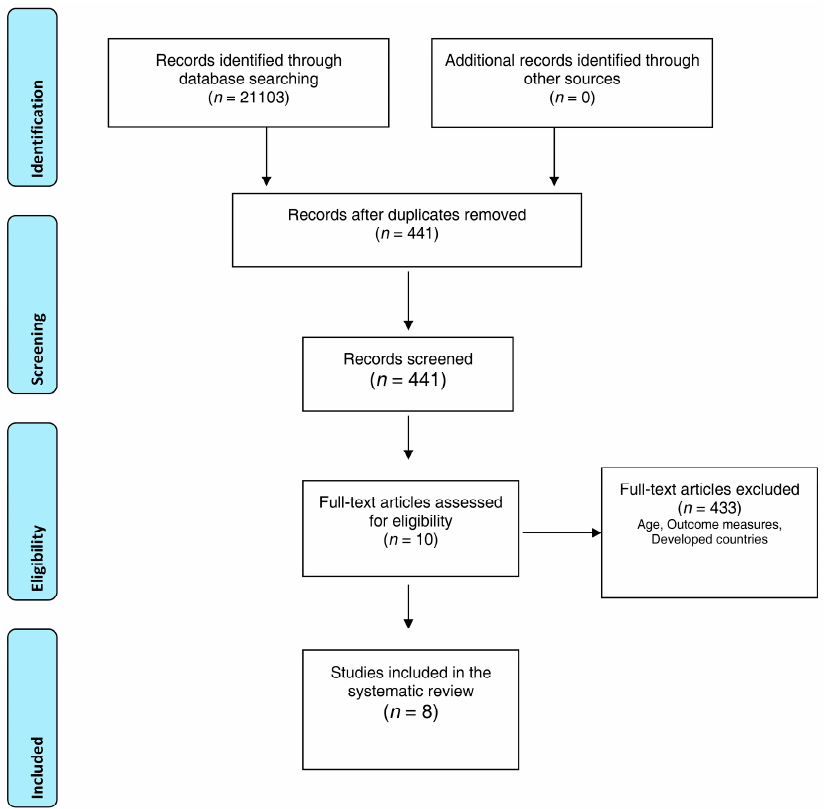
Figure 1. PRISMA flow diagram.